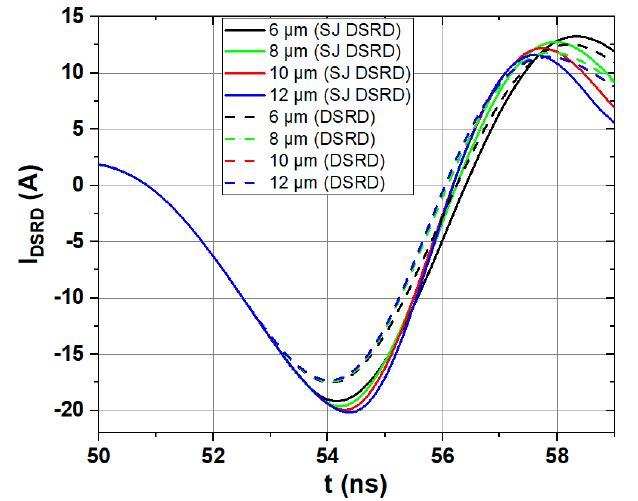
Figure 8. Current waveforms of conventional SiC DSRD and SJ SiC DSRD with T nb of 6 μ m, 8 μ m, Table 2. Comparison of output pulse parameters of conventional SiC DSRD and SJ SiC DSRD with T nb of 6 µ m, 8 µ m, 10 µ m, and 12 µ m.